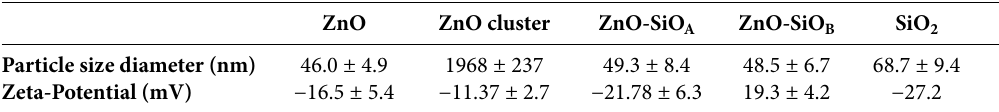
Table 1: The particles size distributions and zeta potential measurements of ZnO NPs, ZnO NCs, and SiO 2 -coated ZnO (A&B) and SiO